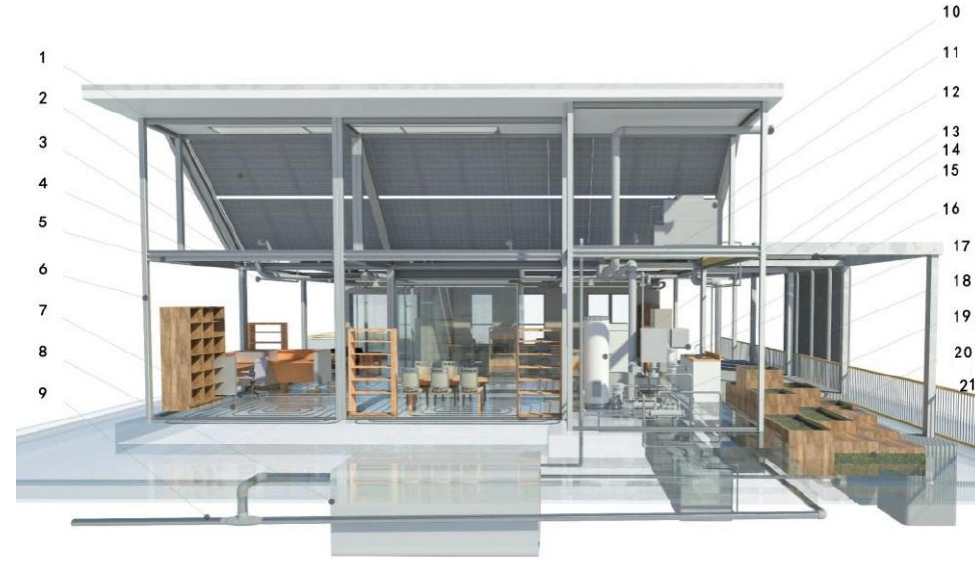
Figure 22. Collaborative modeling contents across disciplines. Table 7. Collaborative modeling contents across disciplines.